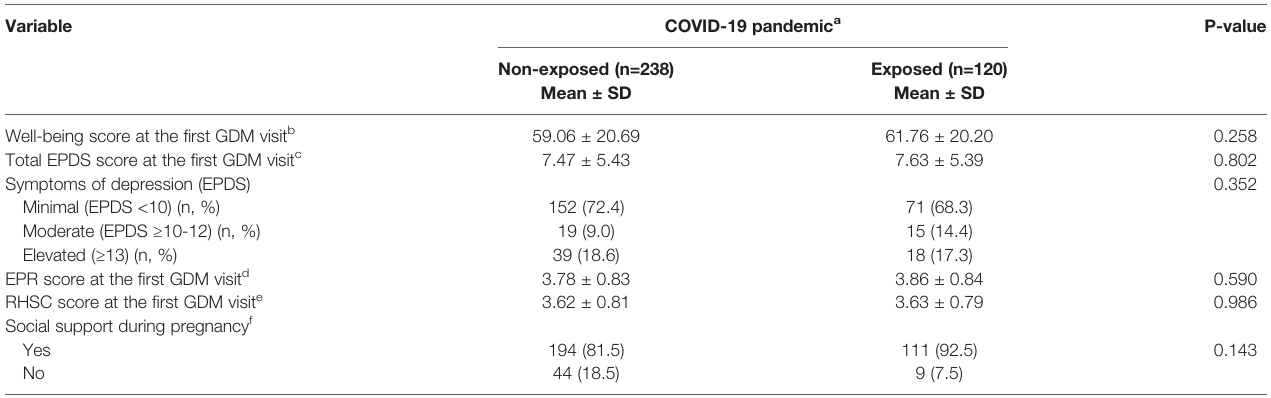
TABLE 5 | Maternal mental health outcomes during pregnancy a year before and during the